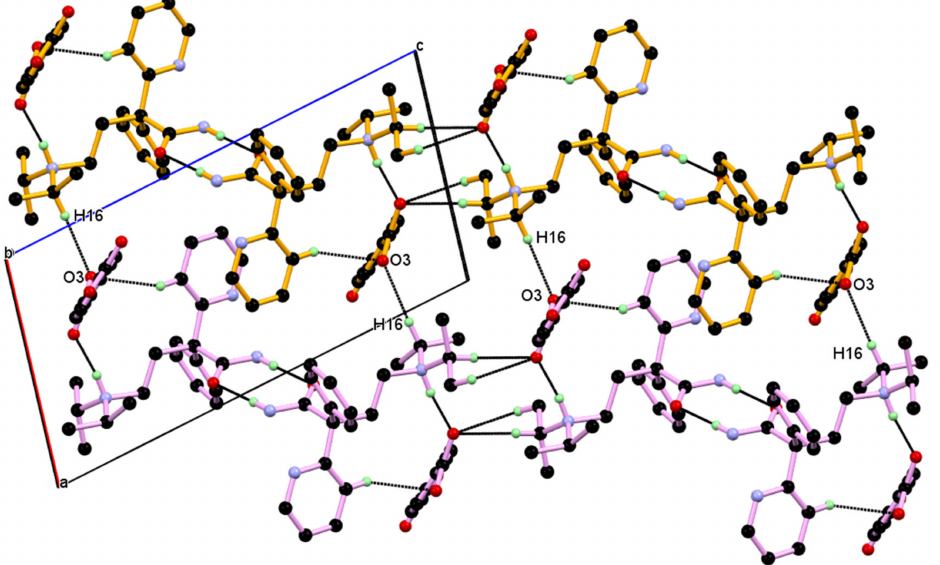
Figure 6. Packing of dimeric unit view down the b -axis. The neighboring dimeric unit is associated through C–H ··· O